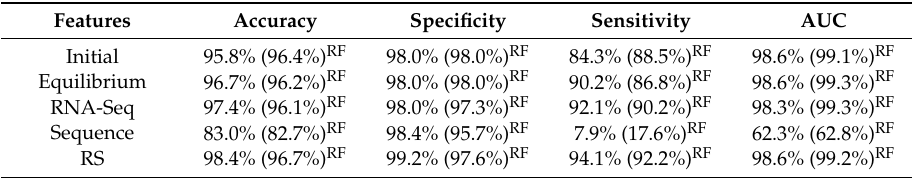
Table 3. Comparison results of different features with Rotation Forest.